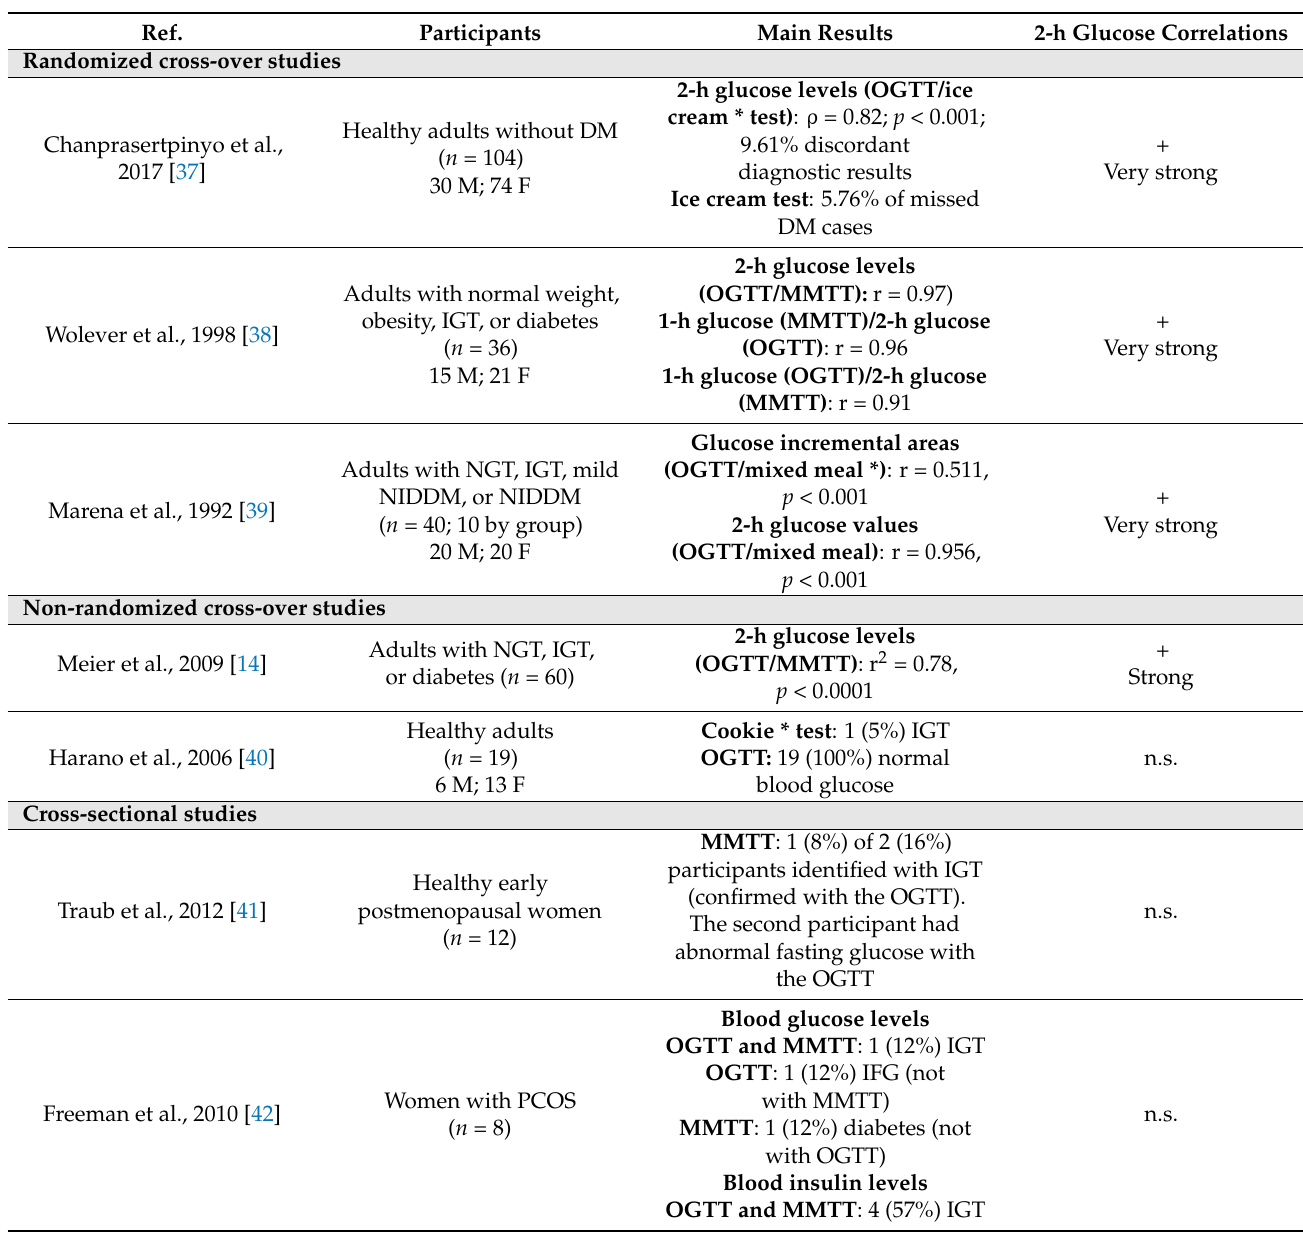
Table 1. Characteristics and main results of the selected studies comparing the metabolic effects of the oral glucose tolerance test to the meal tolerance